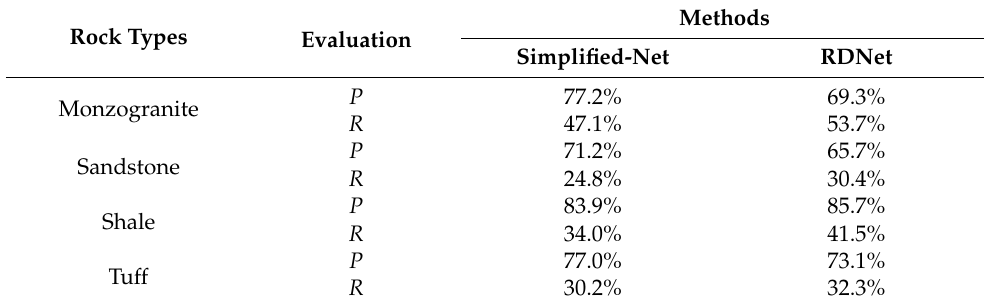
Table 6. The best model performance of Simplified-Net and RDNet on four types rock lithology.